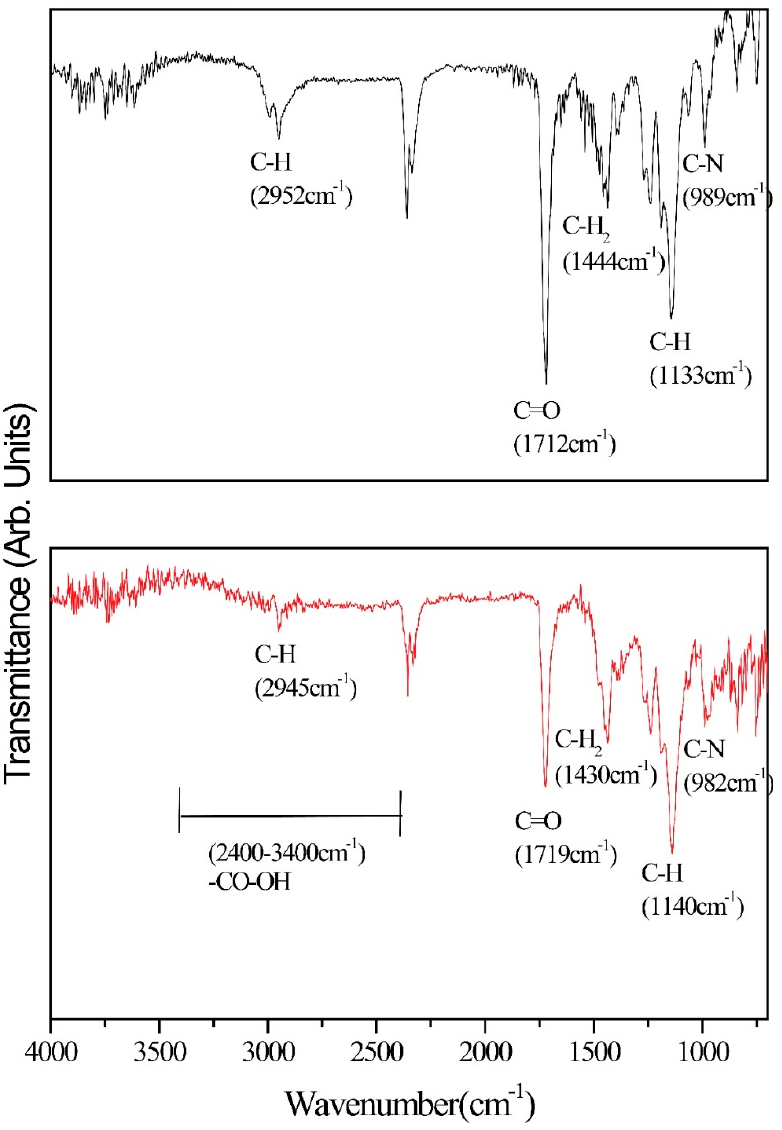
Figure 7. ( a ) FT-IR spectrum of LEVA/PVP/PMMA microparticles before hydrolysis. ( b ) FT-IR Figure 7. ( top ) FT-IR spectrum of LEVA / PVP / PMMA microparticles before hydrolysis. ( bottom ) FT-IR spectrum of LEVA/PVP/PMMA microparticles after hydrolysis. spectrum of LEVA / PVP / PMMA microparticles after